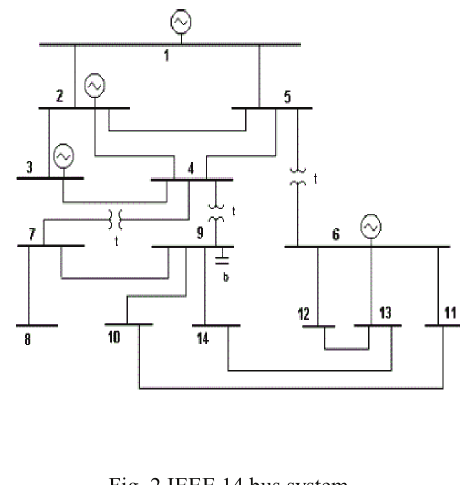
Fig. 2 IEEE 14 bus system